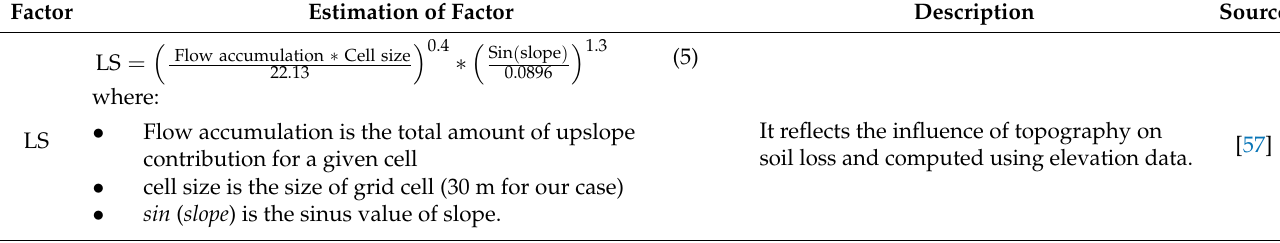
C factor denotes the rate of soil loss associated with a land use class and management practices and calculated using land cover classification of the study area from the classified satellite data. P factor reflects the rate of soil loss associated with support conservation practices such as contour farming, strip cropping, and terracing.